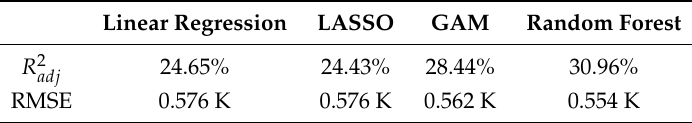
and RMSE for the different models. adj